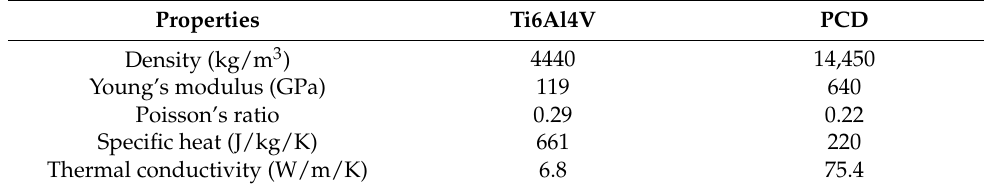
Table 3. The material parameters of tool and workpiece